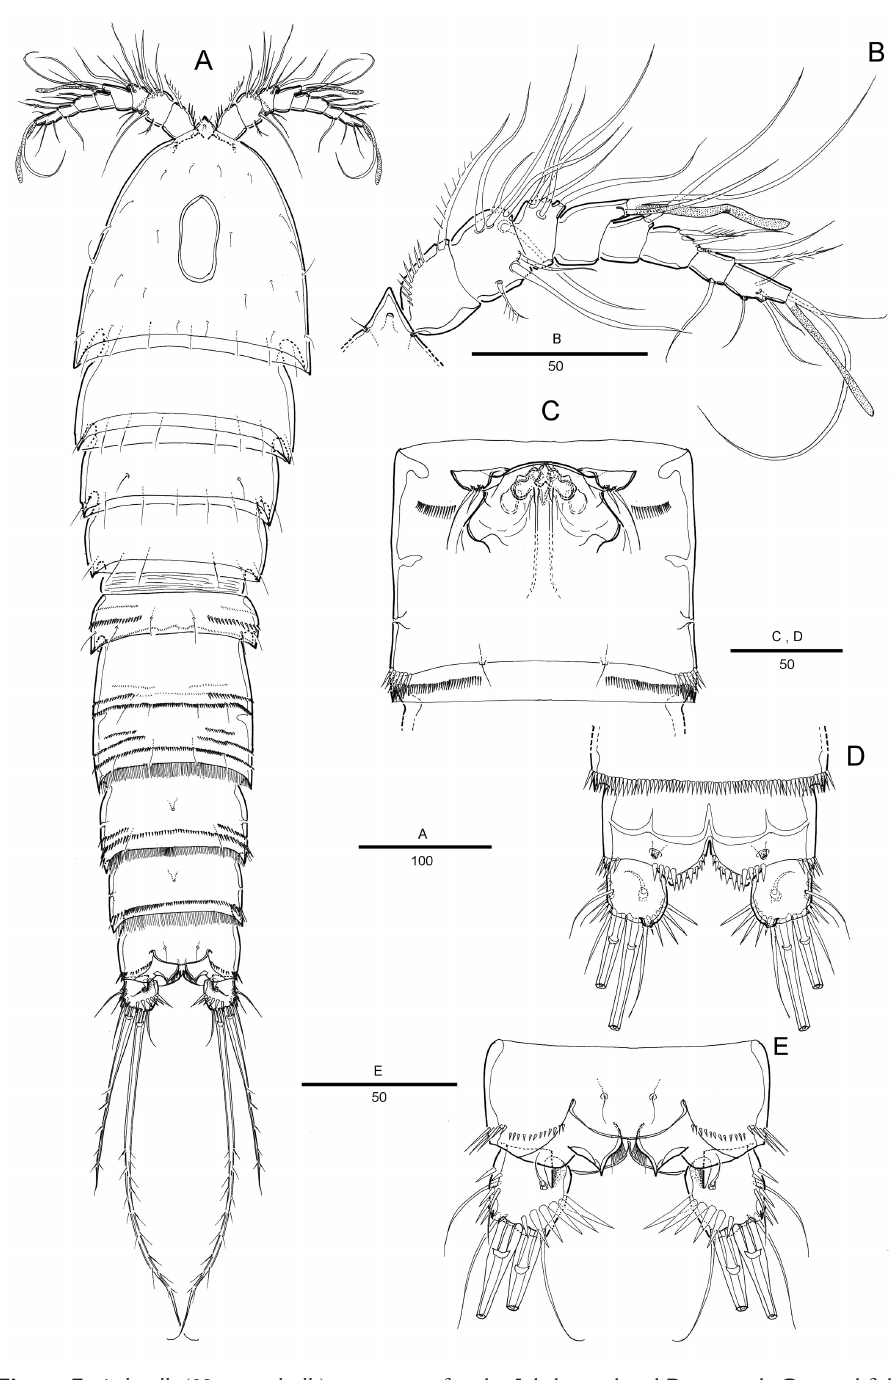
Figure 7. Attheyella ( Neomrazekiella ) tessiae sp. n. female: A habitus, dorsal B antennule C genital field D anal somite and caudal rami, ventral; E anal somite and caudal rami,